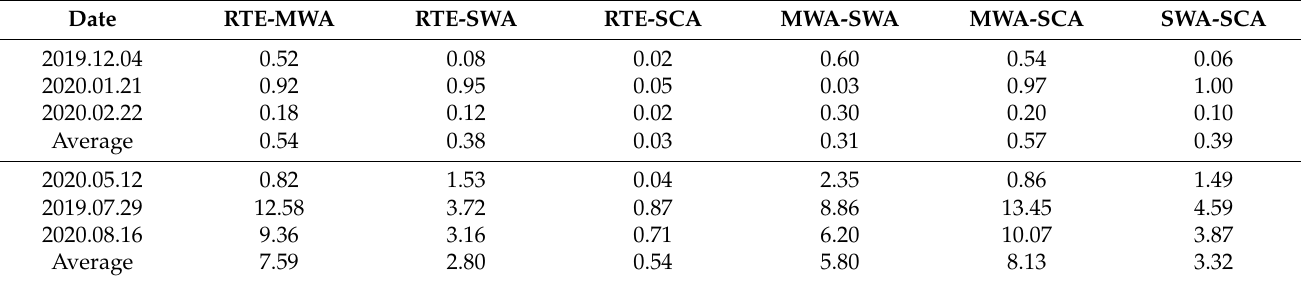
Figure 5. The statistical map of LST retrieval results of four algorithms in winter. ( a ) are the statistics results of LSTs in winter. ( b ) are the statistics results of LSTs in summer. Table 1. The differences (in absolute values) in the average LST values between the four algorithms for any two